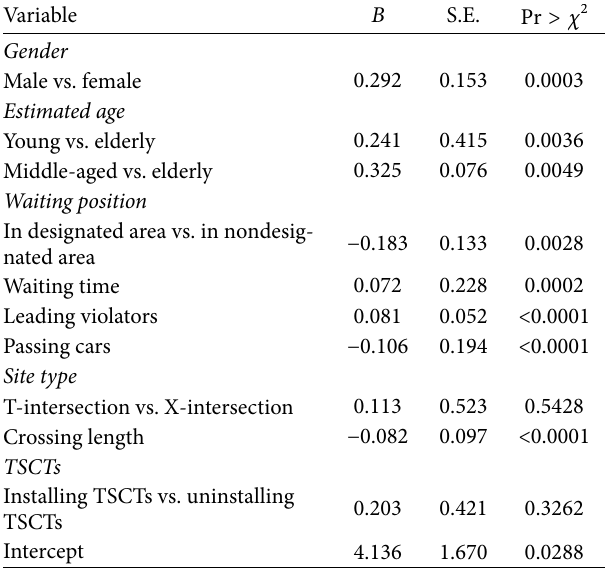
Table 10: Logistic regression model for all